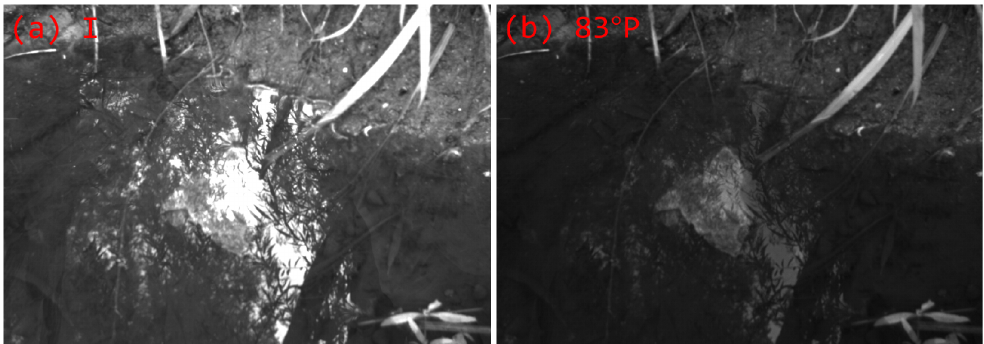
Figure 9. Comparison between optical intensity image and optical polarization image in case